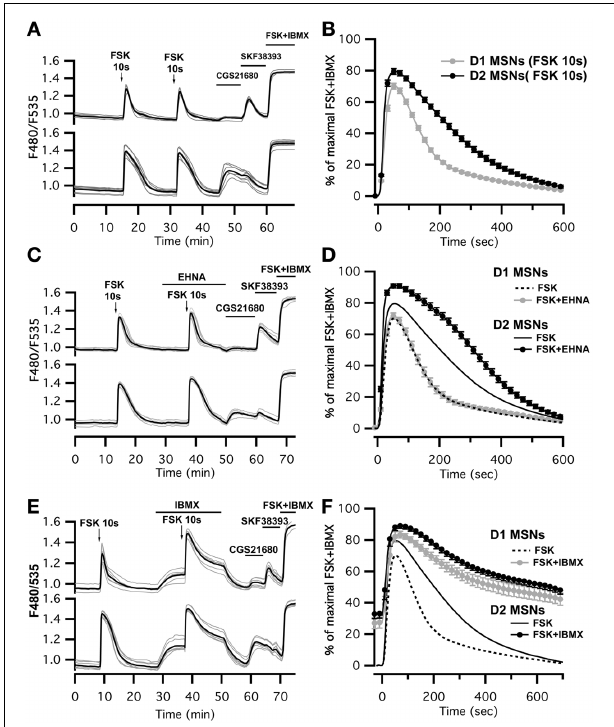
FIGURE 3 | Brief (10s) application of FSK (13 µ M) produced stronger and longer lasting cAMP responses in D 2 MSNs than in D 1 MSNs. (A,C,E) cAMP signals were measured in wide-field imaging with Epac-S H150 biosensor during the application of a 10s pulse of FSK alone (A) , in the presence of EHNA (C) or IBMX (E) . Each trace on the graph indicate the Epac-S H150 emission ratio of an individual neuron. Traces were separated on the basis of their response to the A 2A agonist CGS21680 (1 µ M) or D 1 agonist SKF38393 (1 µ M). (B) Mean responses in D 1 ( n = 112) and D 2 ( n = 122) MSNs to brief FSK stimulation. (D,F) Mean responses in D 1 and D 2 to brief FSK stimulation in the presence of EHNA (10 µ M) or IBMX (200 µ M). Thin dashed and solid lines represent the mean responses in D 1 and D 2 MSNs to brief FSK alone, for comparison. IBMX strongly attenuated the differences between D 1 ( n = 17) and D 2 ( n = 21) MSNs. EHNA increased the cAMP signaling in D 2 MSNs ( n = 19), but had no effect in D 1 cells ( n = 19). Markers are plotted sparsely for clarity; error bars represent SD .